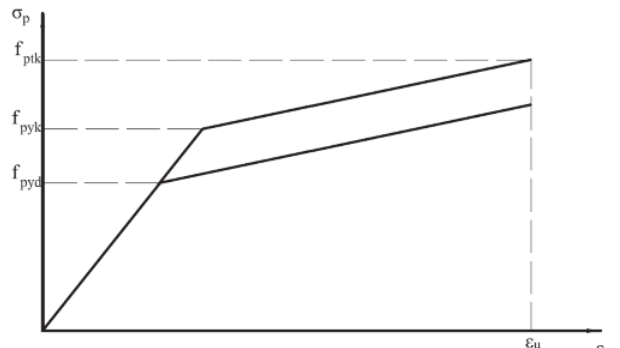
Stress-strain relationship for the prestressed steel